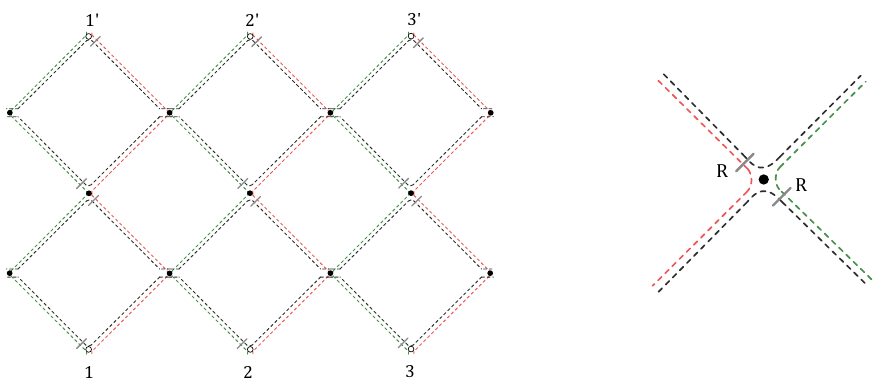
0) , (∆ 0 , ˙ ‘ ) , while black lines are associated k , ‘ k , k , k 0) and (∆ 0 , ˙ ‘ ) . a , ‘ a , a , a